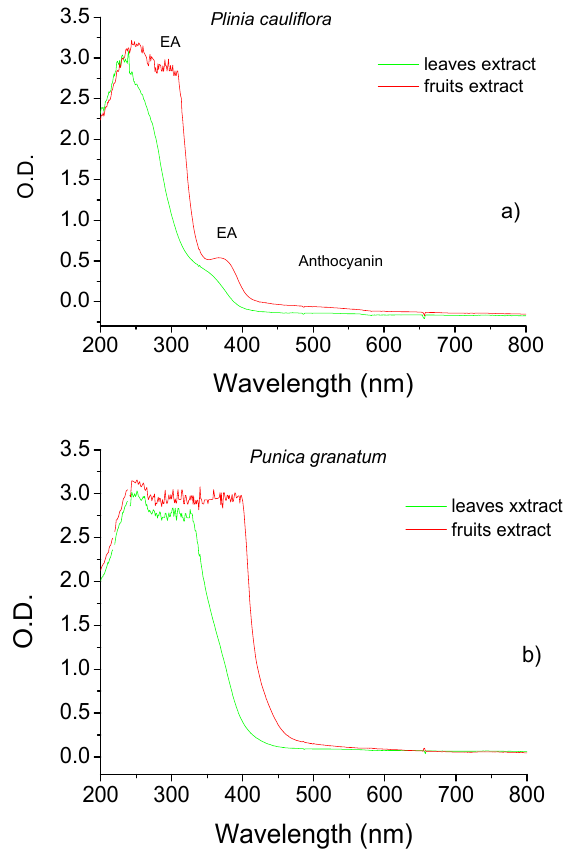
Figure 2. UV-vis spectra of ( a ) Leaves and fruit extracts of Plinia cauliflora and ( b ) Leaves and fruit extracts of Punica granatum .